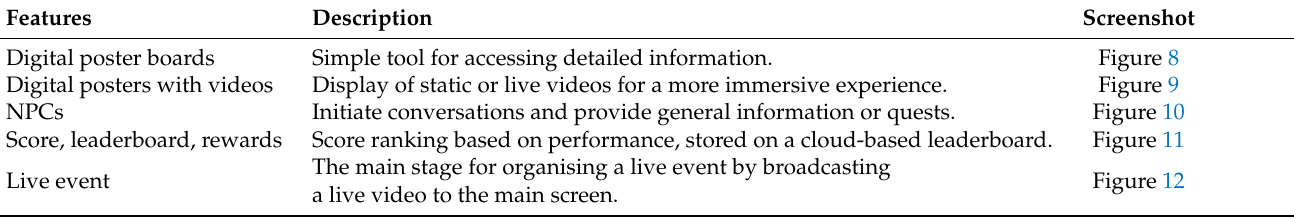
Table 3. Summary of various features of the metaverse platform for conveying information.